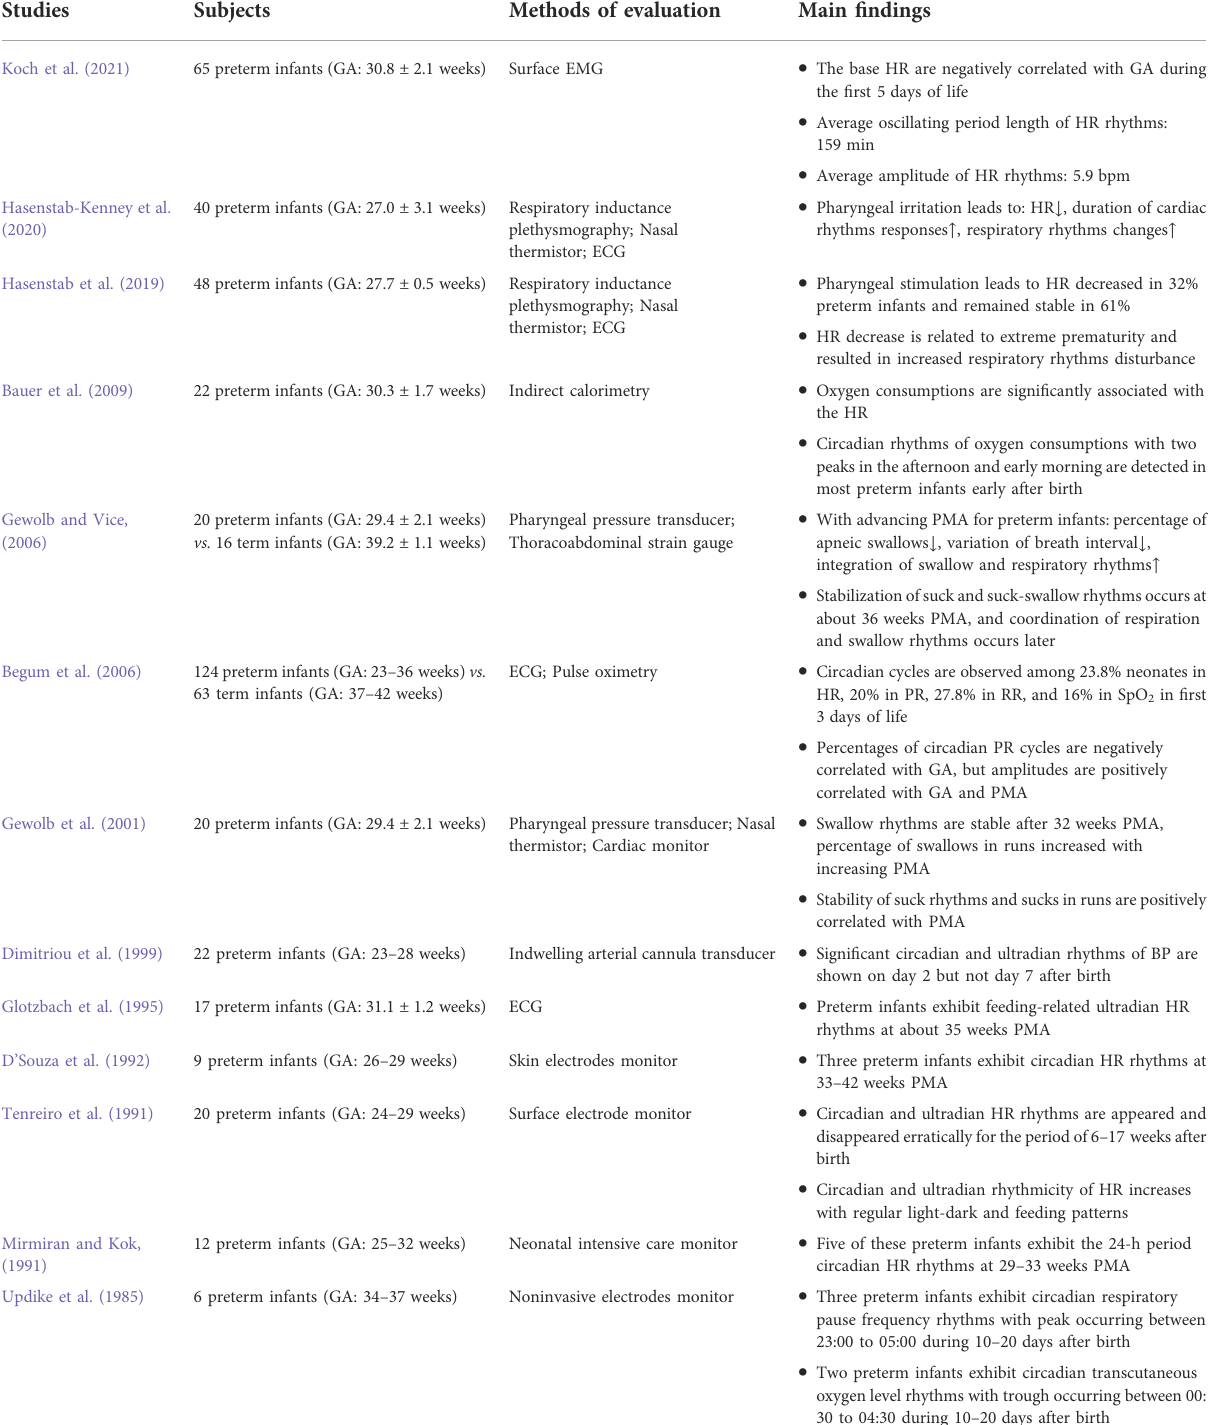
TABLE 2 Studies about the cardiorespiratory rhythms in preterm